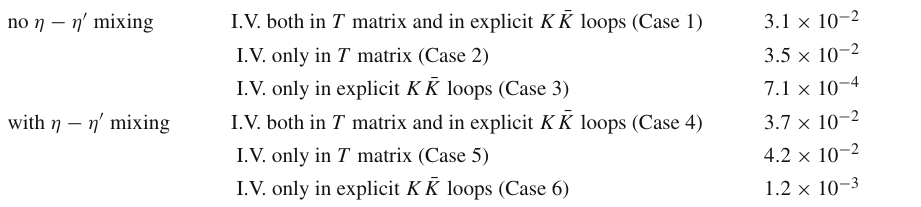
Table 3 values of R with different assumptions. (In the table, I.V. denotes isospin